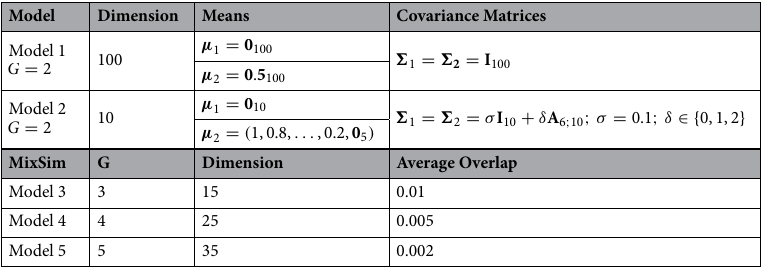
Table 1. Description of the model parameters. The matrix I n is the identity of dimension n . The matrix A i ; n is an n × n matrix with all entries equal to zero, except the i -th position in the main diagonal, which equals 1. Models 1 and 2 consist of two Gaussian clusters; models 3–5 are Gaussian mixture models with fixed levels of